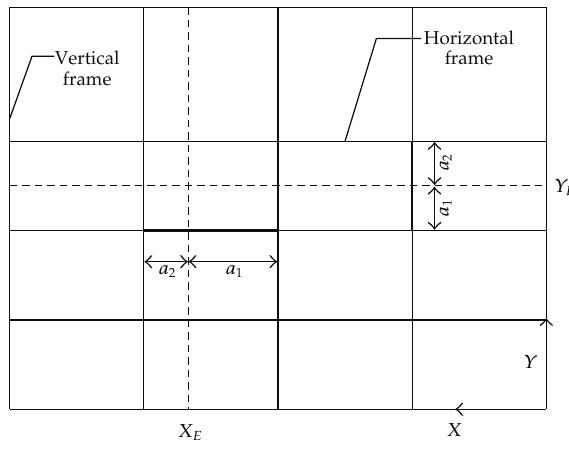
Figure 15: Definition of the main dimensions of